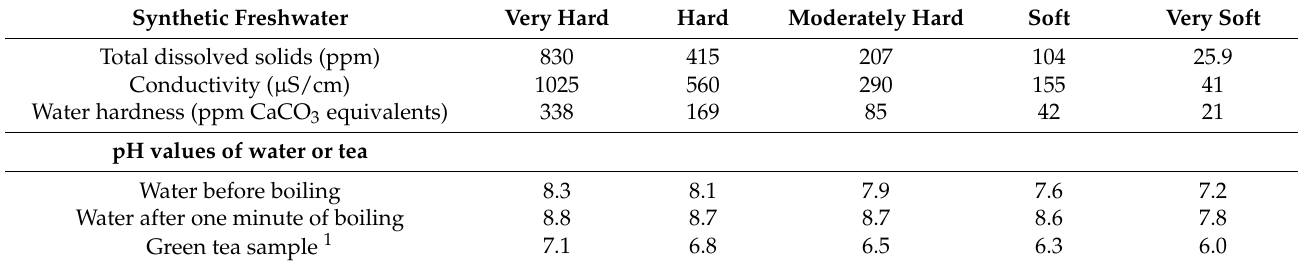
Table 3. Properties of synthetic freshwater and green tea prepared with synthetic freshwater. Synthetic Freshwater Very